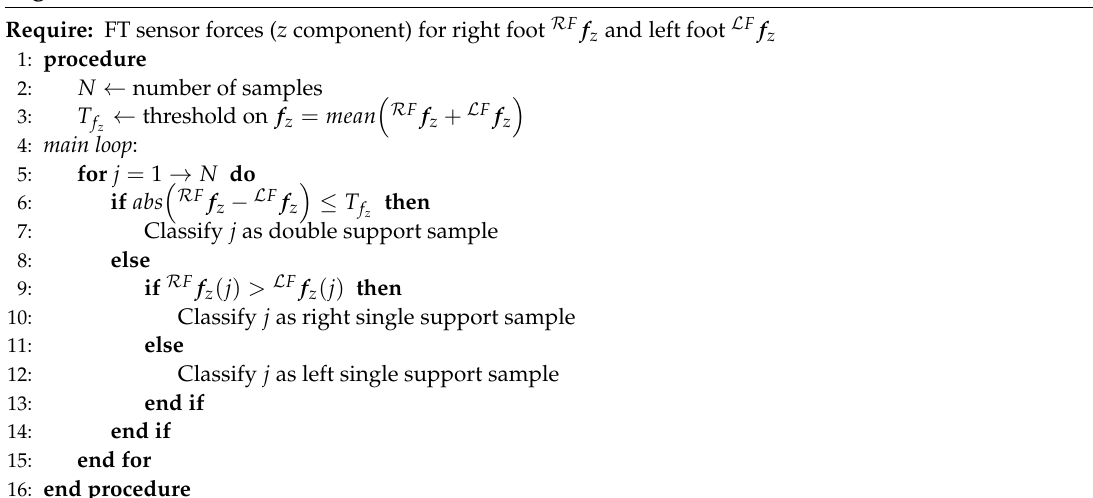
Algorithm 1 Offline Feet Contact